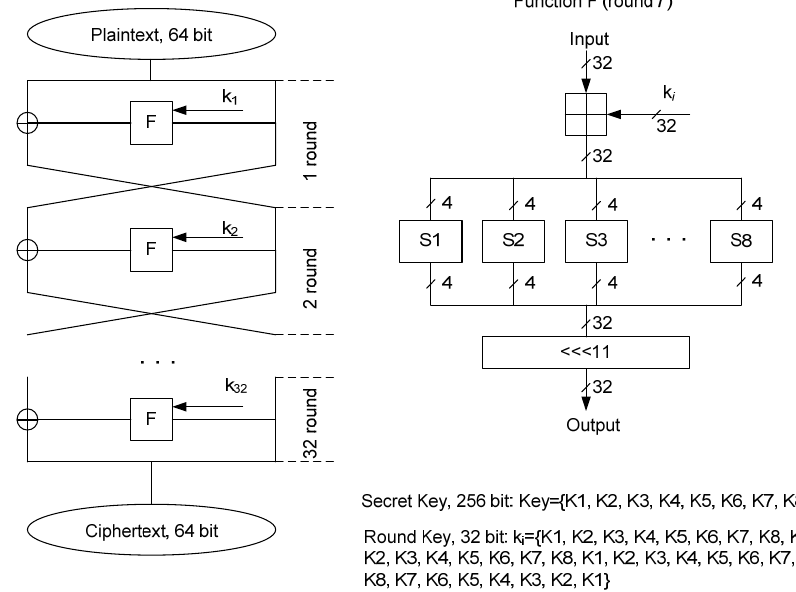
Figure 1. Magma encryption algorithm.